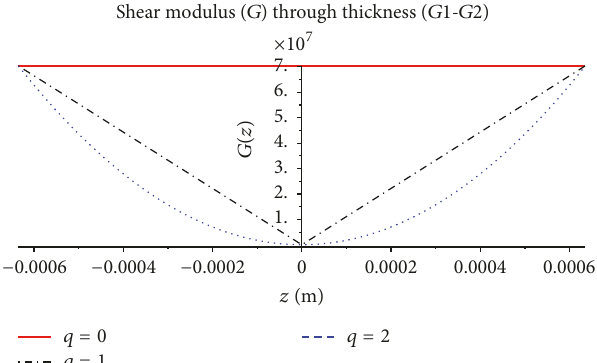
Figure 4: Predicted Young’s modulus for different metal-graphene